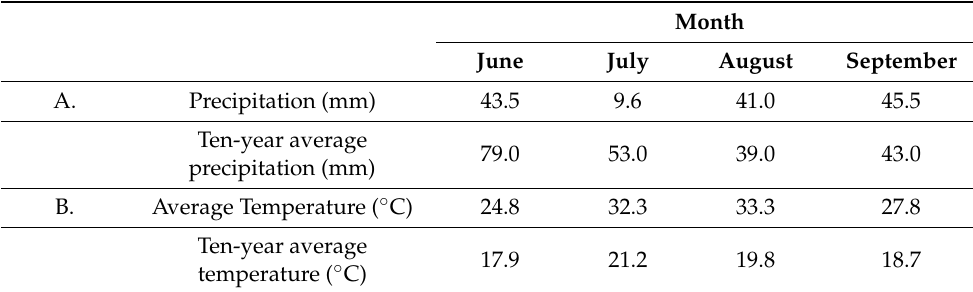
Figure 1. The genotypes used: differences in color and shape of the fruit. The experiment was conducted in Vranovo during a year when the average air tem- peratures were higher than the ten-year average. During the period when the vegetative organs developed and the eggplant plants flowered, average temperatures were in the range of 21.0–27.8 ◦ C. The total amount of precipitation at in Vranovo (139.6 mm) was lower compared with the multi-year average precipitation (Table 2). Table 2. Total precipitation (mm) (A) and average monthly air temperature ( ◦ C) (B) in Vranovo for June–September 2015 and their ten-year averages